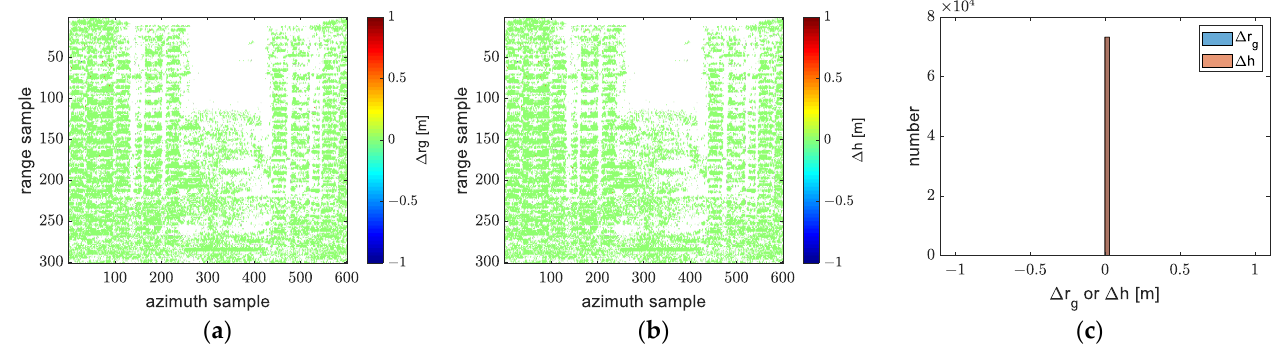
Figure 28. The ground range and height error between model 6 and model 5: ( a ) the ground range error; ( b ) the height error; ( c ) a histogram of the ground range and height